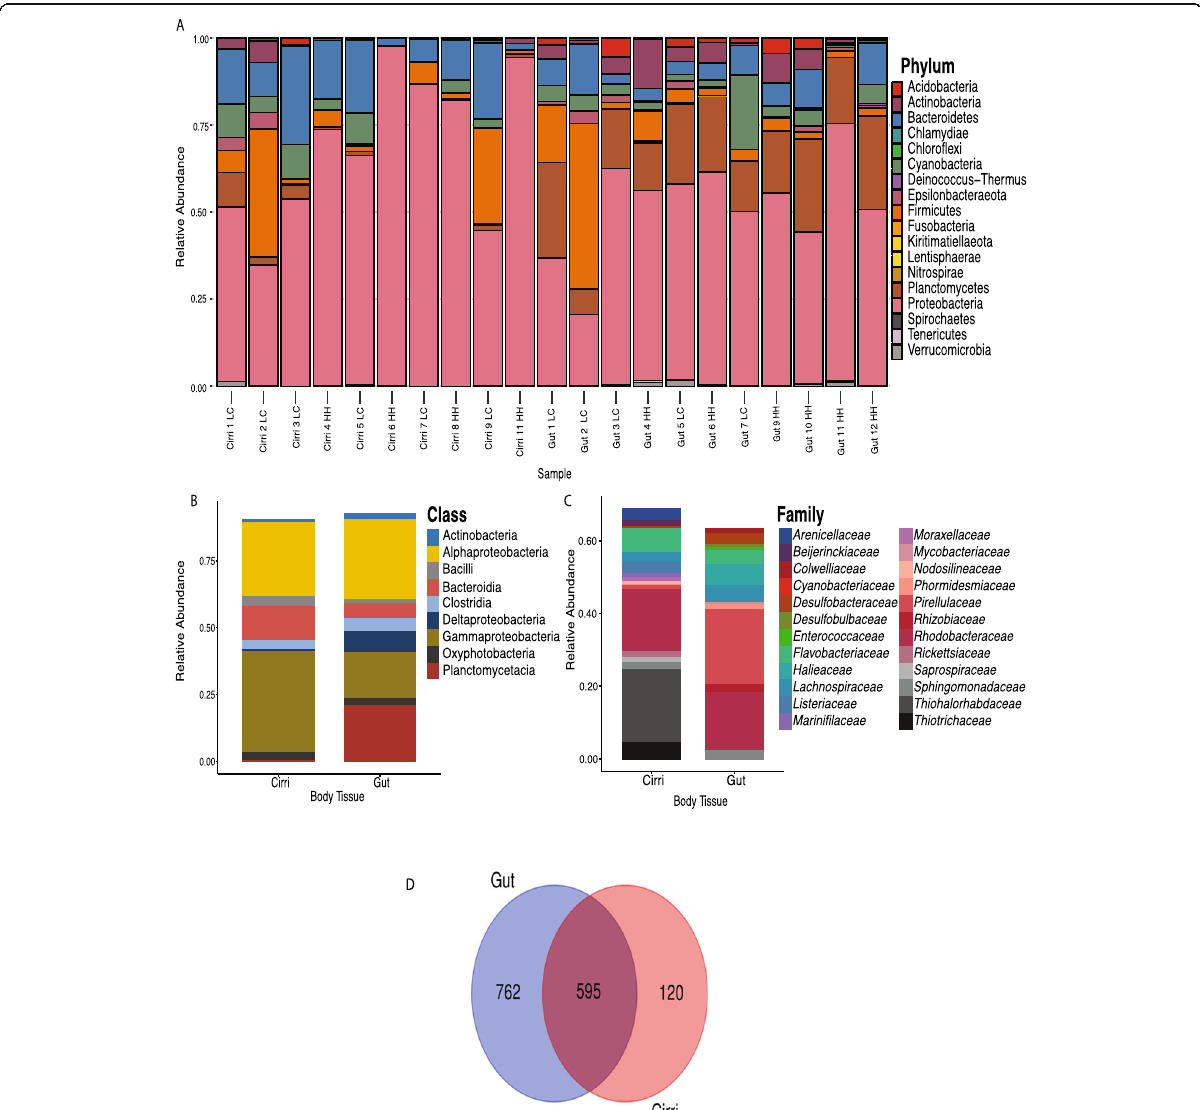
Fig. 2 Relative abundance of ASVs. a Relative abundance of ASVs of each sample at the phylum level. b Mean relative abundance (> 0.05) of ASV at the Class and c family level of gut and cirri. d Venn diagram of ASVs unique to and shared between cirri and